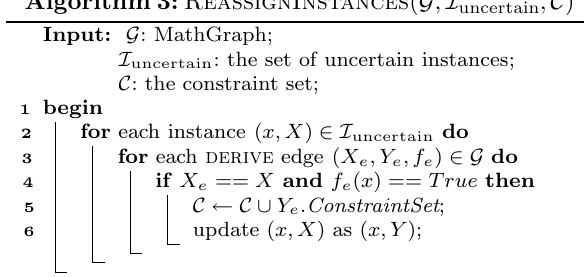
Algorithm 3: ReassignInstances (